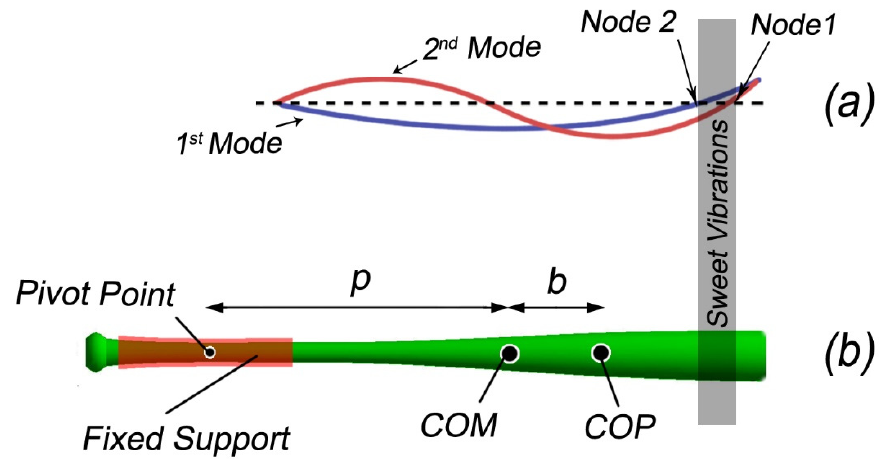
Figure 1. ( a ) Location of nodal points on a baseball bat. ( b ) Location of COP on the